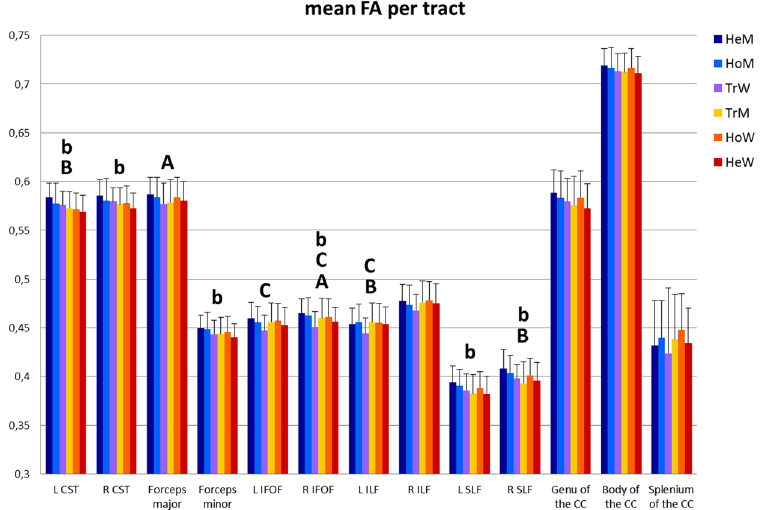
Figure 3. Group differences in mean ( ± SD) FA per tract were analysed with a Sex (male/female sex assigned at birth) by Gender identity (male/female) multivariate ANOVA including all cisgender and both transgender groups, with age and Kinsey scores included as covariates. Upper case letters denote significant ( p < 0.05) (A) interaction effects, (B) main effects of Sex, and (C) main effects of Gender identity. Also, results of a Sex (male/ female sex assigned at birth) by Sexual orientation (homo-/heterosexual) multivariate ANOVA including the four cisgender groups, with age as covariate, are displayed. Lower case letters denote significant (a) interaction effects, (b) main effects of Sex, and (c) main effects of Sexual orientation. HeM = heterosexual cisgender men, HoM = homosexual cisgender men, TrW = transgender women, TrM = transgender men, HoW = homosexual cisgender women, HeW = heterosexual cisgender women, CST = cortico-spinal tract, IFOF = inferior fronto- occipital fasciculus, ILF = inferior longitudinal fasciculus, SLF = superior longitudinal fasciculus, CC = corpus callosum, L = left, R =